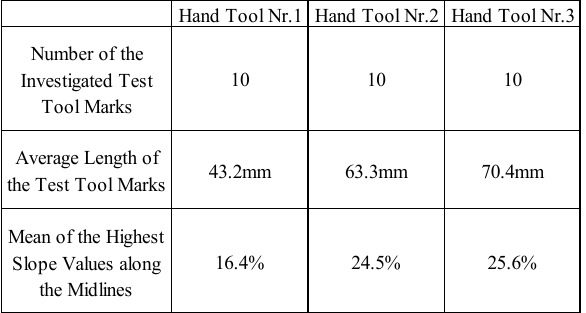
Table 2. The evaluation of the tool mark midlines The two smaller replicas have almost the same head shapes; however, the tool marks of the first adze are significantly shorter and the highest slope values along the midlines are also lower. After the investigation of the three adze handles, this issue could be explained in CAD environment (Figure 5). The angles between the heads and their handles were determined by extracted standard geometries and these results are the following: Hand Tool Nr.1: 49.3°; Hand Tool Nr.2: 56.4°; Hand Tool Nr.3: 54.9°.